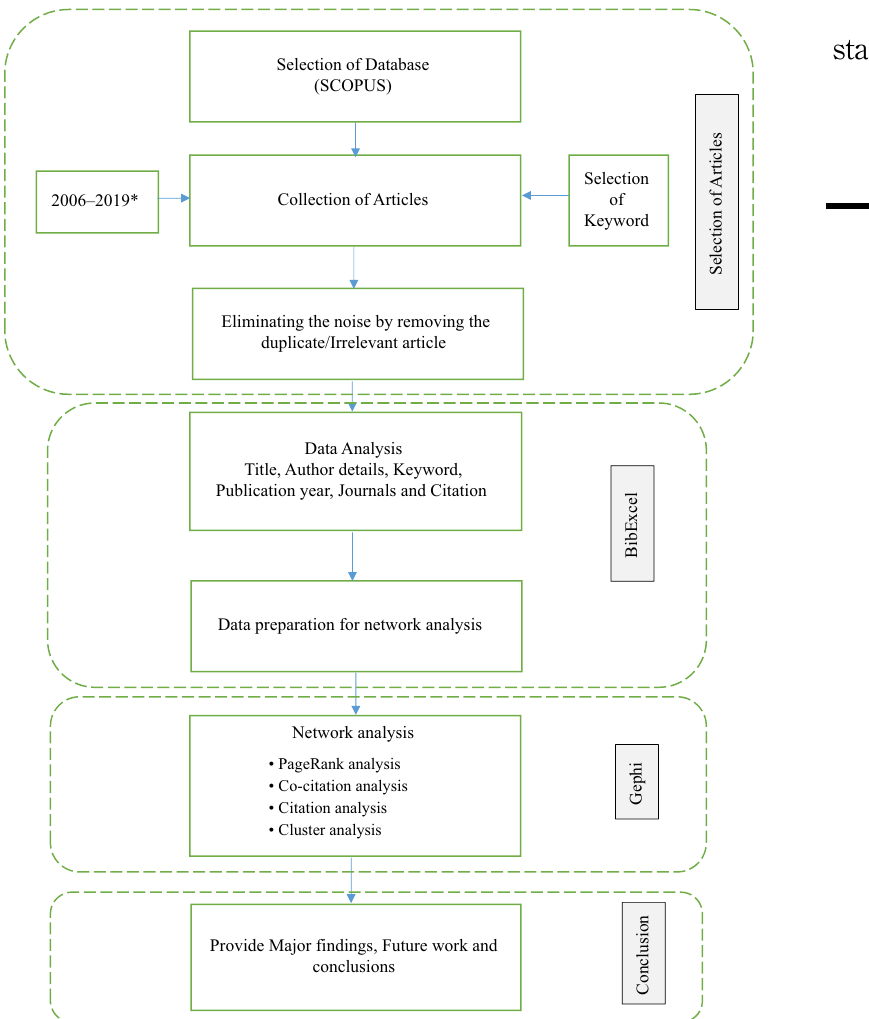
Figure 1. Flowchart for the